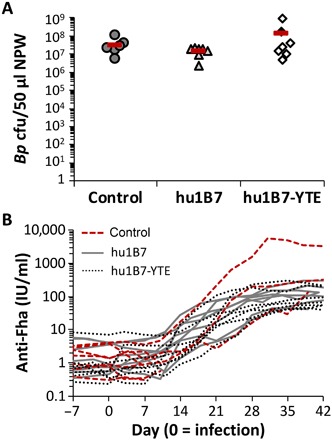
Anti-PTx prophylaxis did not affect initial colonization with B. pertussis or antibody response to Fha.(A) Nasopharyngeal washes collected from each baboon 3 to 4 days after infection were serially diluted and plated on selective media to quantify the B. pertussis CFU recovered (group means shown as a bar; n = 7 per group). No significant differences between treatment groups were observed (ANOVA; α = 0.05, P = 0.3). (B) Serum anti-Fha titers were determined by ELISA twice weekly throughout the experiment. The baboons had varied, but not significantly different, primary responses to Fha by treatment group; compared on day 27/28 by ANOVA (α = 0.05, P = 0.08; note that only three of seven control animals survived to this date).